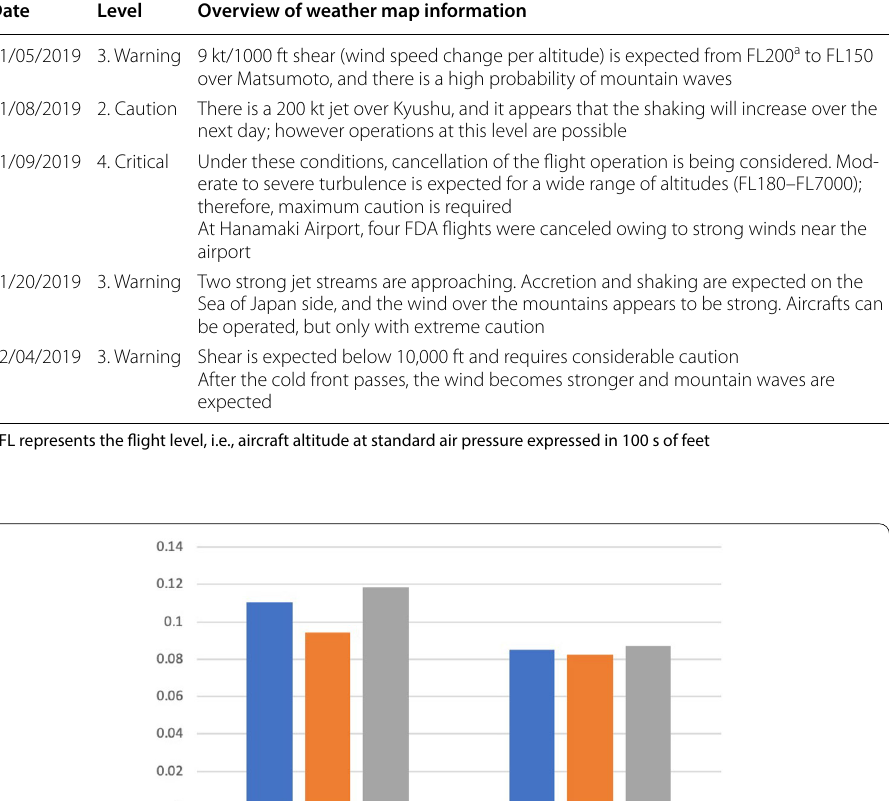
Table 6 Verification of the predicted turbulence days using the weather map Date Level Overview of weather map information